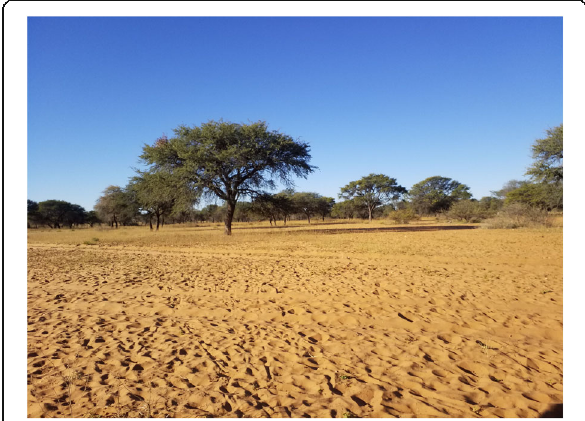
Fig. 4 Area beyond the DTP in Ozongarangombe; photographed 2nd August,